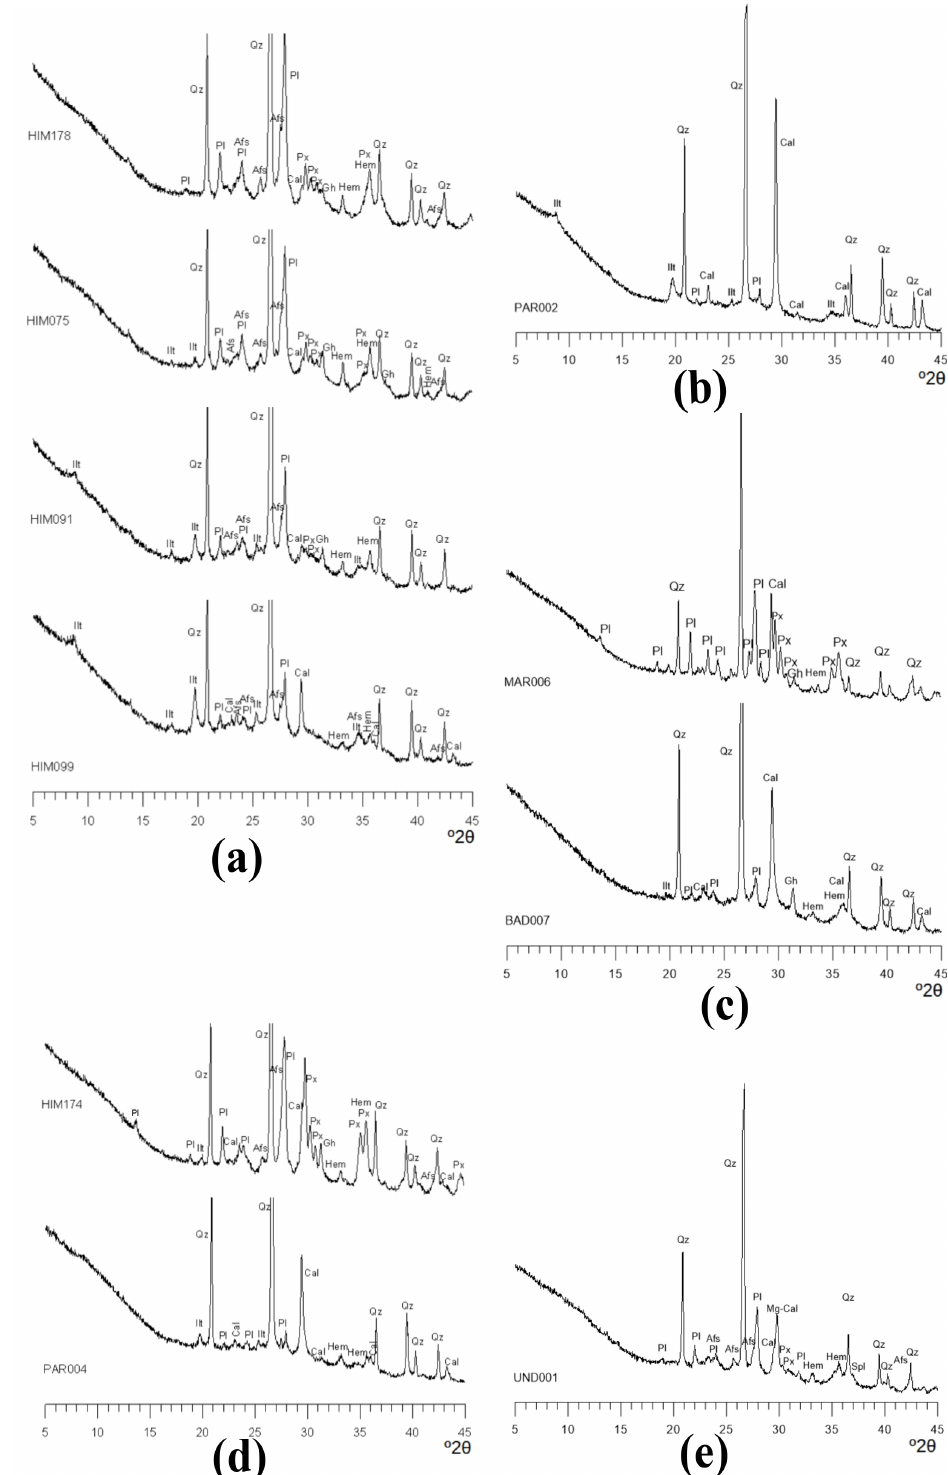
Figure 12. Diffractograms of some of the archaeological individuals discussed by the chemical